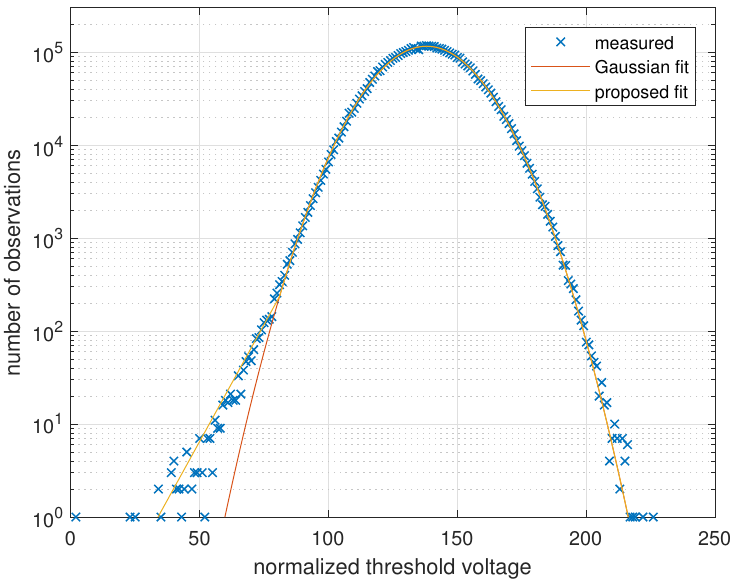
Figure 3. Fitting according to [23] for S 7 at